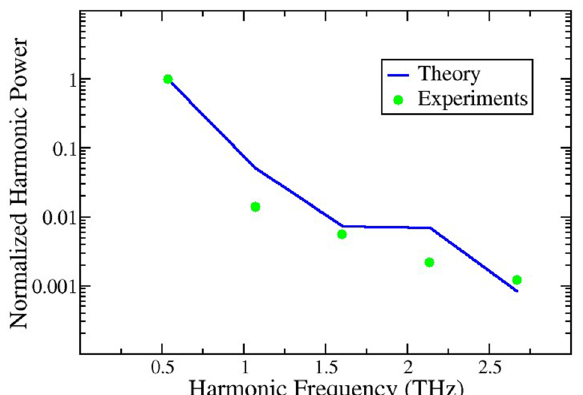
Figure 4. Normalized output power P n / P 3 for the 3rd, 6th, 9th, 12th and 15th harmonics. The input frequency is ν = 178 GHz and α = eEd / h ν = 19.6. Using the vacuum impedance and frequencies in GHz the connection